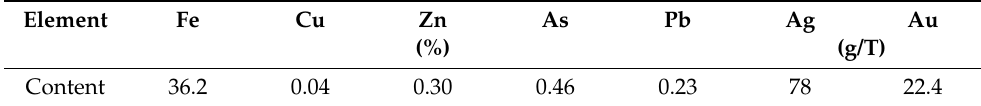
Table 1. Metal content in FeS 2